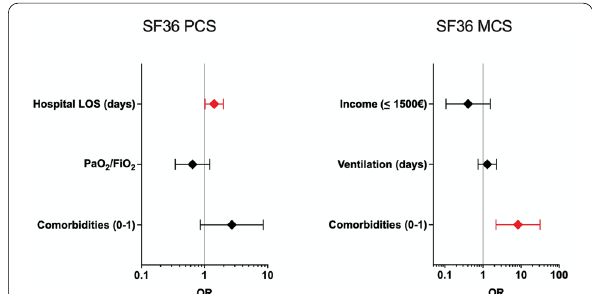
Fig. 4 Multivariable analysis of factors associated with impaired “physical” health-related quality-of-life scale (SF-36 PCS) and “mental” health-related quality-of-life scale (SF-36 MCS) in C-ARDS survivors. The figure shows factors associated with SF-36 physical component summary score (PCS) and SF-36 mental component summary score (MCS) < 40 (dependent variable), the calculated adjusted odds ratios, and the 95% confidence intervals, based on the logistic regression, on the x-axis, and on the correspondent forest plot. In red, variables significantly associated with an impaired quality of life. Reference